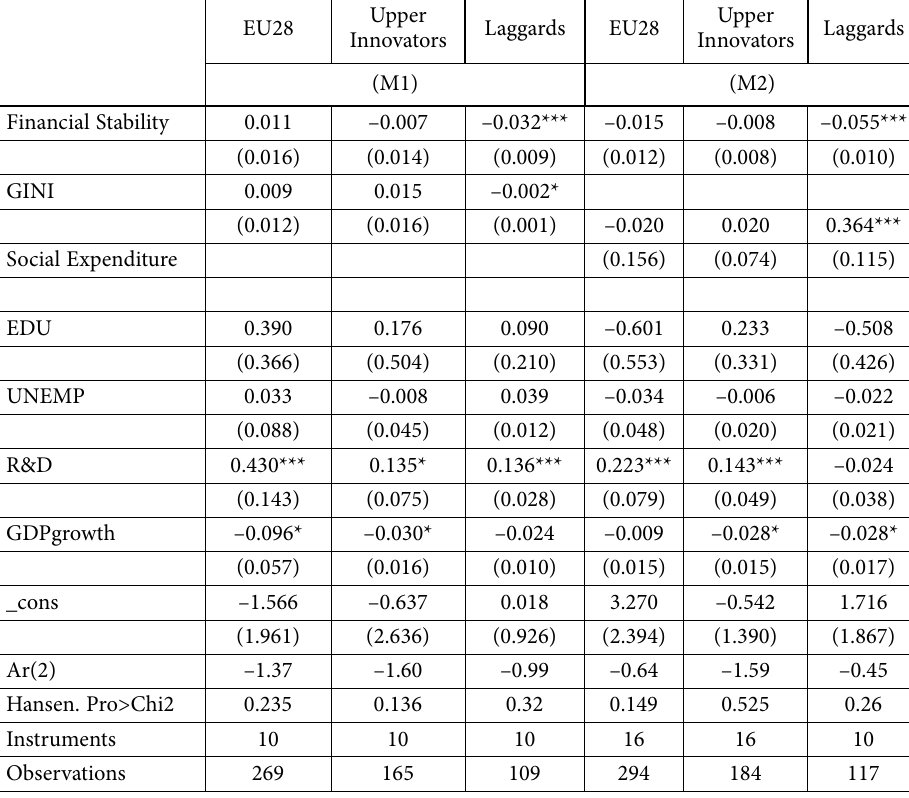
Table 3. Estimation results: innovation scoreboard index as dependent variable